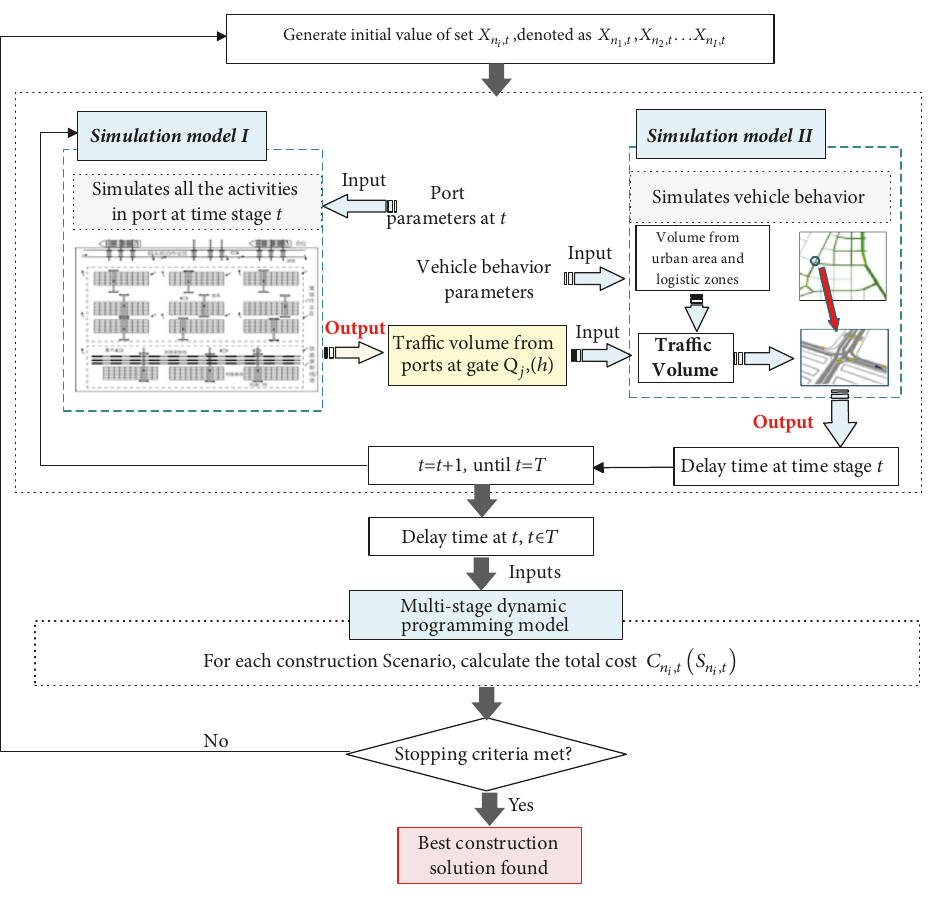
Figure 2: Flowchart of the model